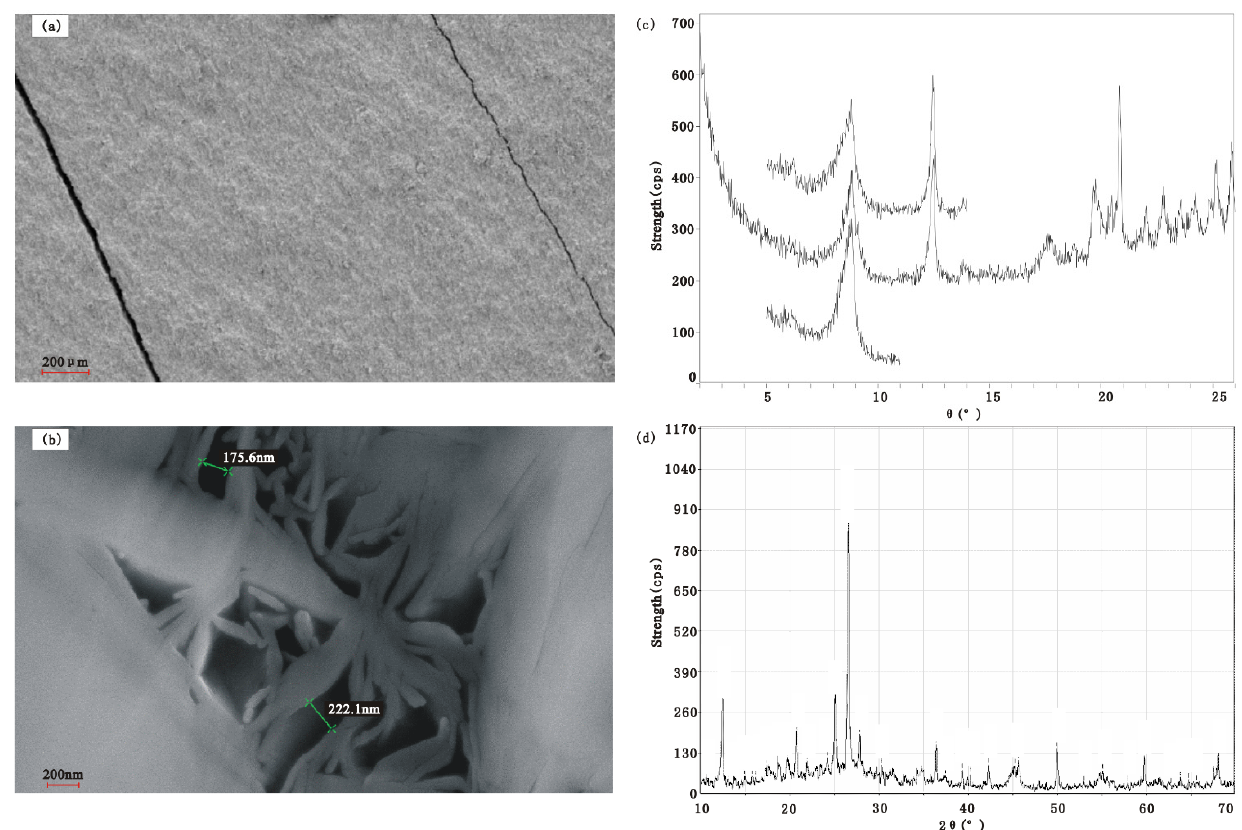
Figure 1. Geological characteristics analysis of shale in Block GL. ( a ) Scanning electron microscope picture for the crack of the shale laminated structure; ( b ) Scanning electron microscope picture for the intergranular void of clay; ( c ) Map for drill core by X-ray diffractometry of the clay; ( d ) Map for whole rock by X-ray diffractometry of the clay.